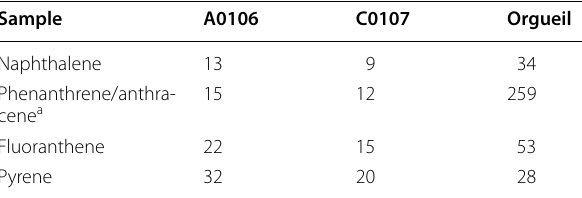
Table 2 Abundances of PAHs in the DCM extracts of Ryugu samples A0106, C0107, and Orgueil; values in nmol/g of